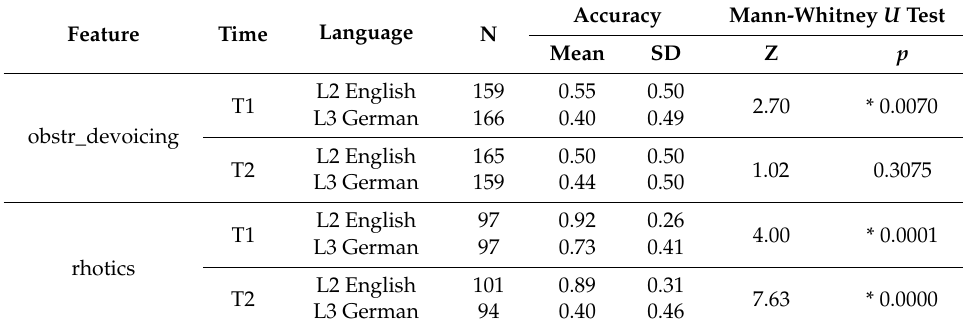
Table 7. Perception accuracy comparison between L2 English and L3 German.